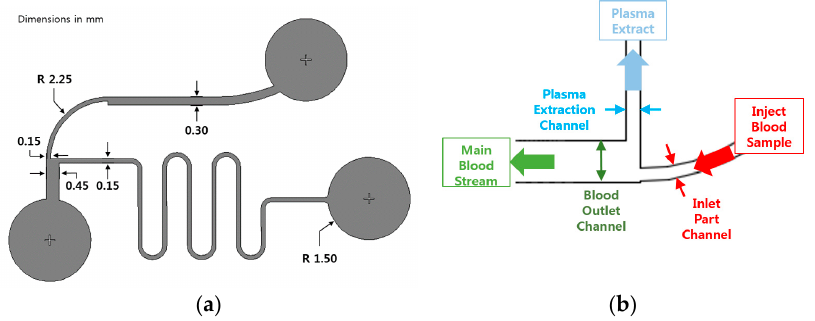
Figure 2. Schematics of ( a ) the designed bifurcation blood plasma separation chip and ( b ) the main separation region of the designed bifurcation blood plasma separation chip.